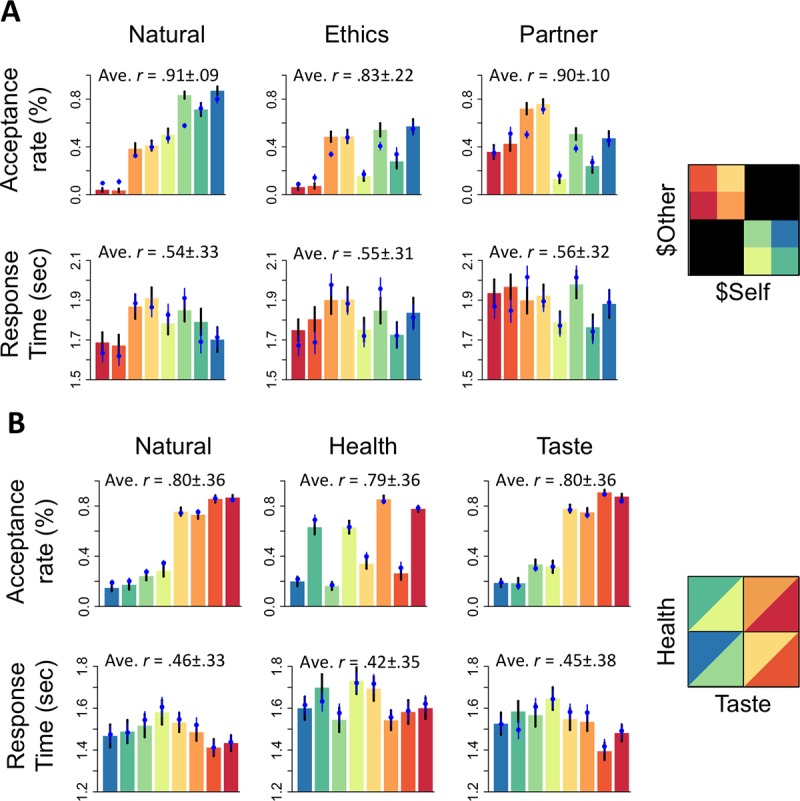
Drift diffusion model (DDM) fits to behavior in both choice tasks.(A) Correspondence in the altruism task between observed acceptance rates (top) and response times (bottom) for different proposal types (bars) and model predictions (blue circles, determined using best-fitting parameters for each subject). On average, subject-level correlation between observed and predicted acceptance rates across trial types was generally quite high. (B) Correspondence in the food task between observed and model-predicted acceptance rates (top) and response times (bottom) for foods of varying taste and healthiness (subject-specific ratings outside the scanner). For illustration purposes, for both tasks model fit to behavior is shown for eight bins created based on the displayed color scheme (right) for variations in choice-relevant attributes (increased attribute values from left to right). Thus, bar colors correspond to trials with specified combination of attributes.